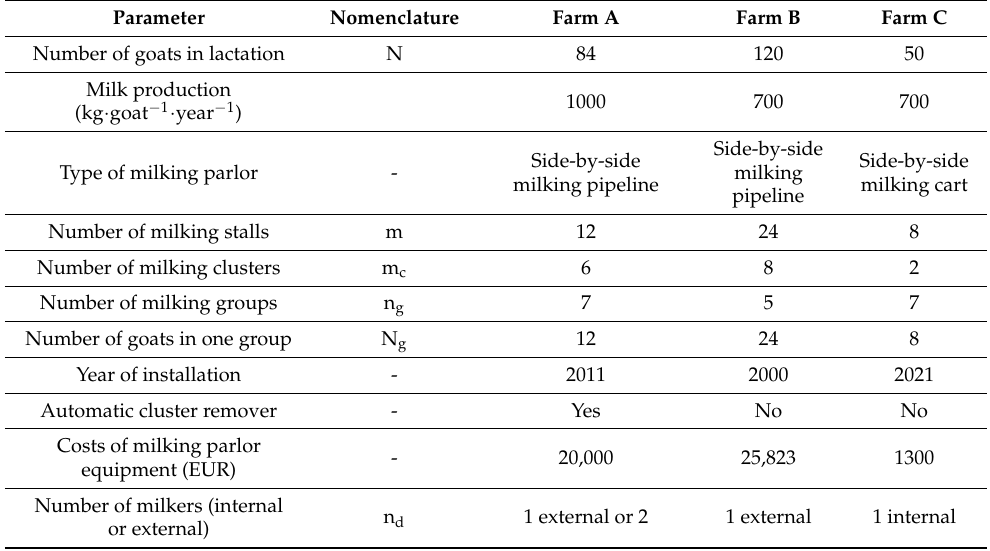
Table 1. Analyzed dairy goats’ farms with milking